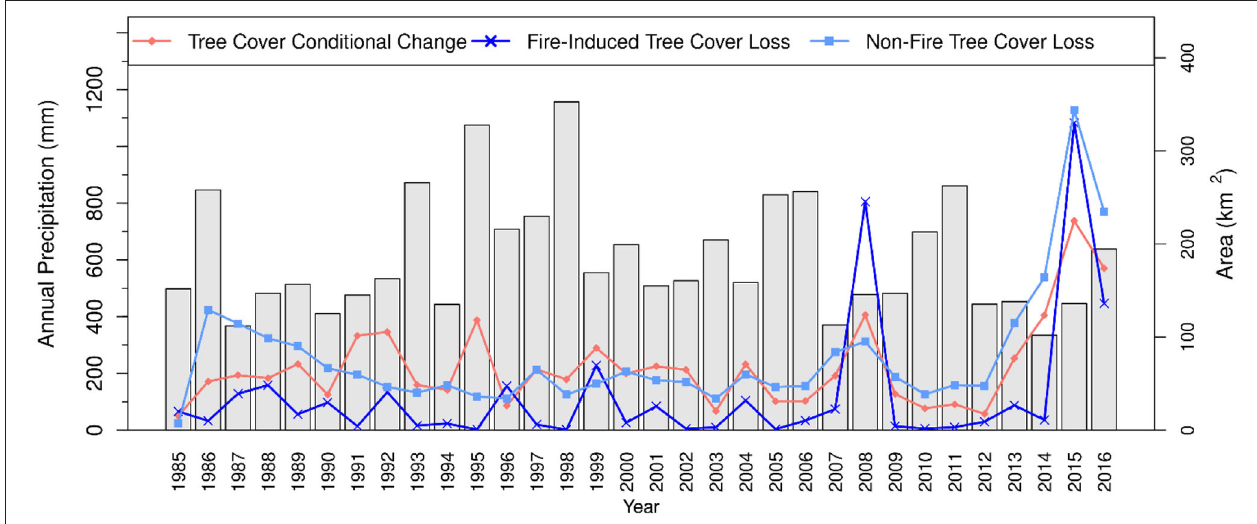
FIGURE 5 | Time series plot showing non-fire and fire-related tree cover change and their interrelationships with interannual precipitation variability across blue oak woodlands, 1985–2016.